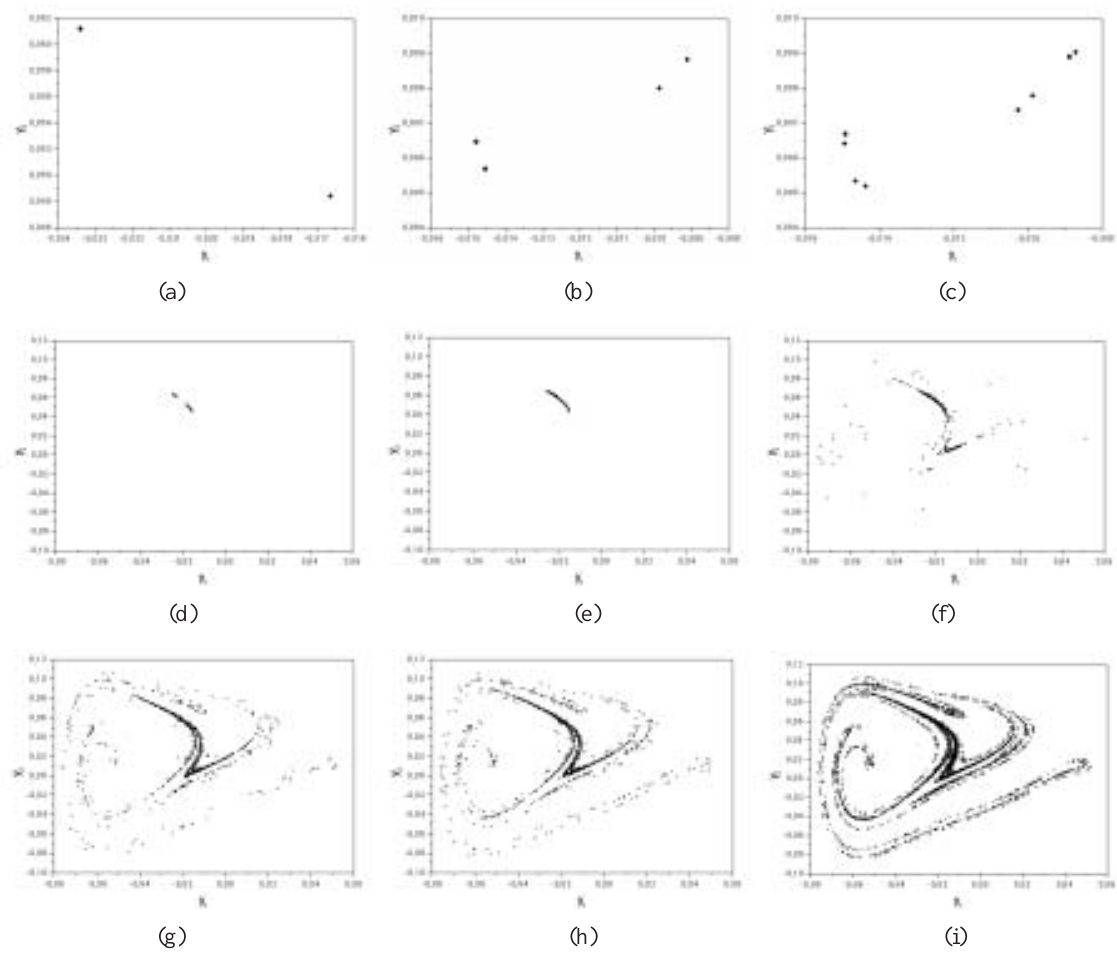
Fig. 4. Evolution of Poincar´e maps due to variation of the force amplitude parameter δ (birth and formation of the chaotic attractor). (a) δ = 0 . 05875 , period-2; (b) δ = 0 . 059 , period-4; (c) δ = 0 . 0592 , period-8; (d) δ = 0 . 0593 , chaos; (e) δ = 0 . 0595 , chaos; (f) δ = 0 . 05965 , chaos; (g) δ = 0 . 059675 , chaos; (h) δ = 0 . 05969 , chaos; (i) δ = 0 . 06 ,